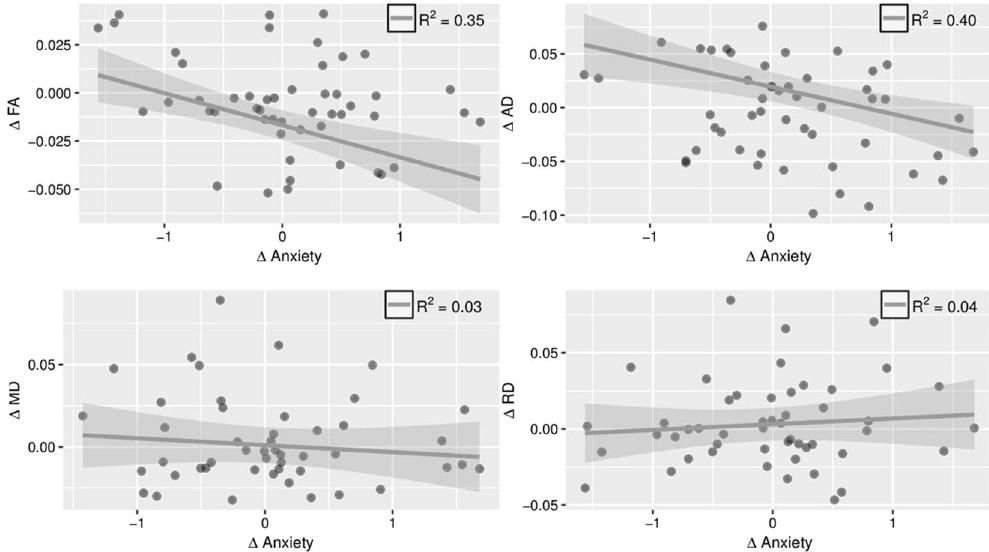
Figure 2. Intrapair anxiety differences are negatively associated with intrapair uncinate fasciculus differences in the left hemisphere FA ( t = − 2.22, p = 0.032) and AD ( t = − 2.38, p = 0.022). No significant relationships were observed for right UF.